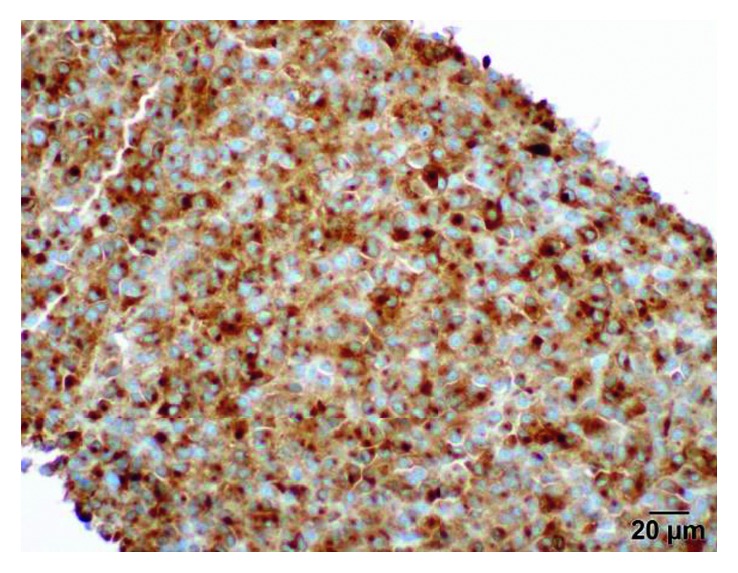
Liver biopsy (MART).